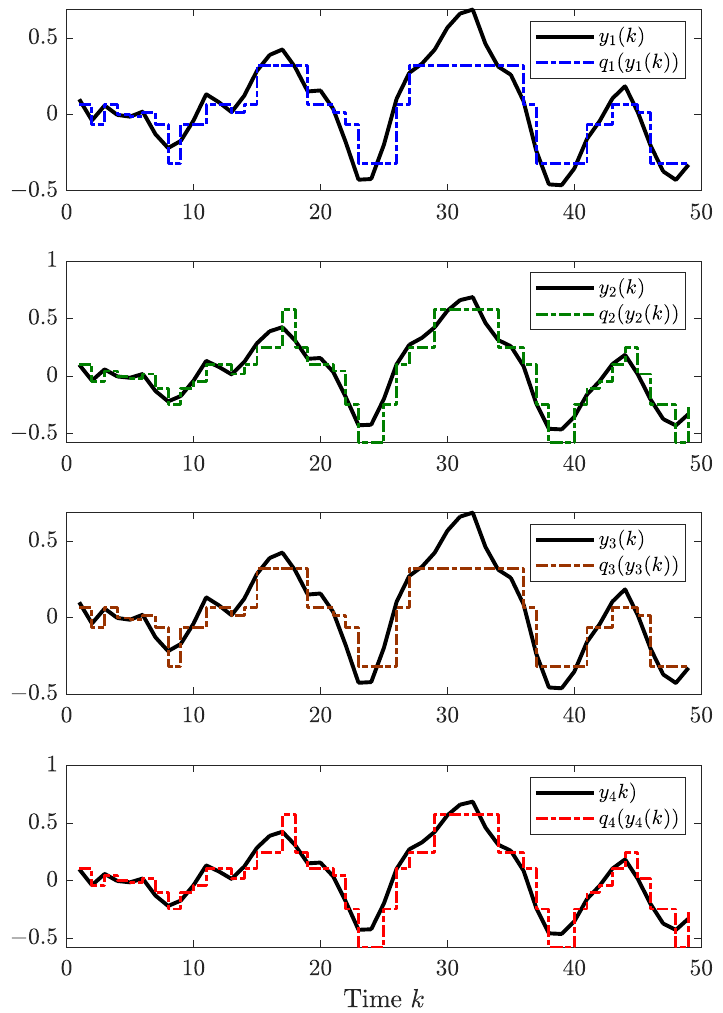
Figure 8. The actual measurement y ( k ) , and the quantified measurement q i ( y i ( k )) , i =